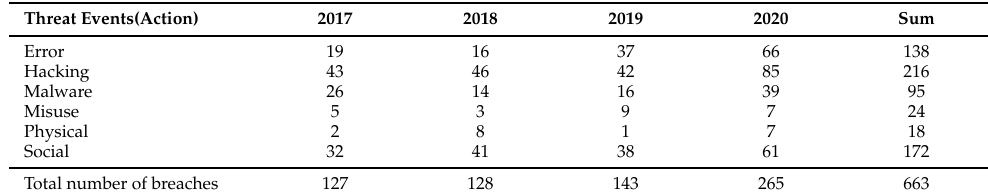
Table 9. Number of security beaches in HE sorted by action and year from Verizon Data Breach Investigation reports 2017–2020